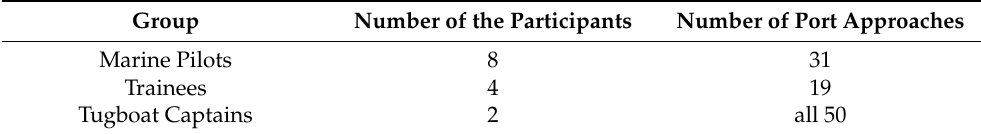
Table 2. Table of the